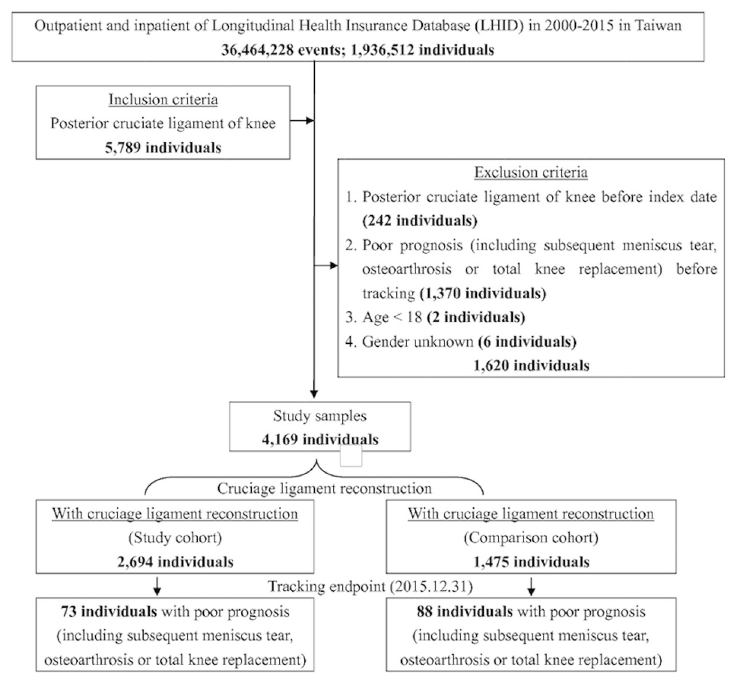
Fig 1. The flowchart of study sample selection from National Health Insurance Research Database in